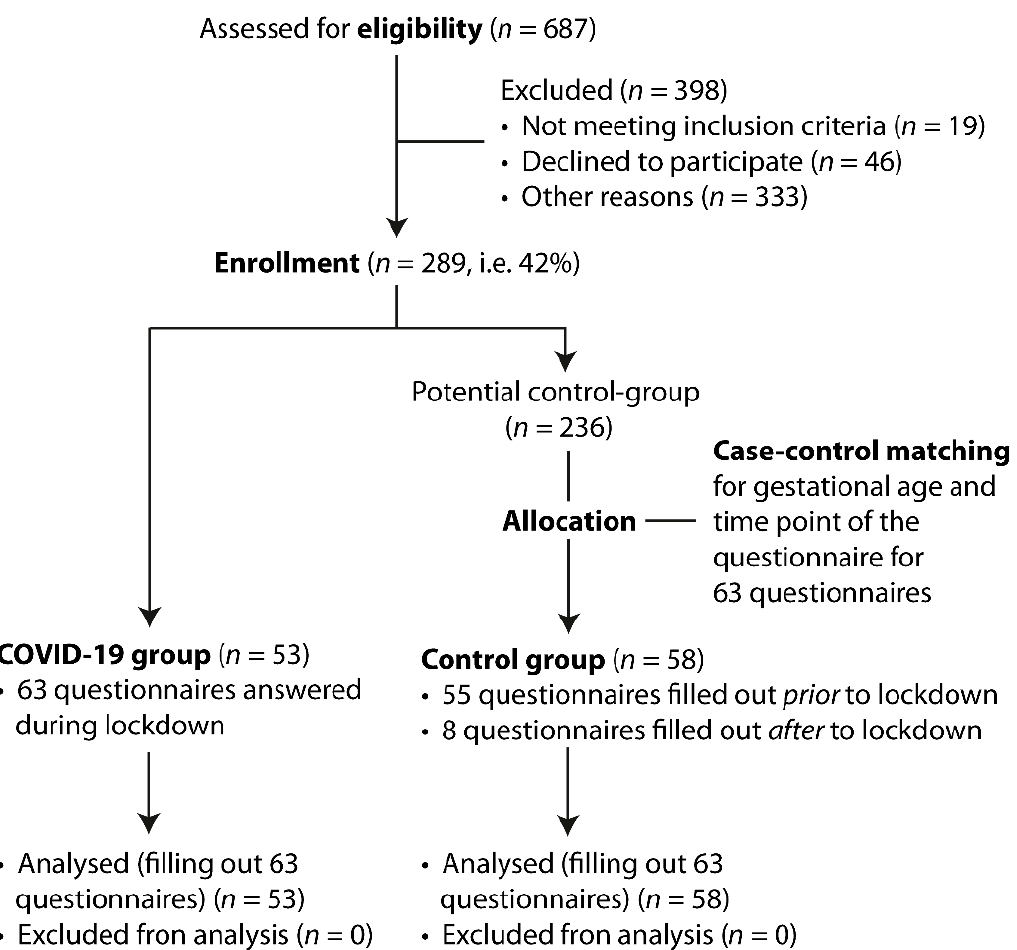
Figure 1. CONSORT diagram for enrollment and study allocation.